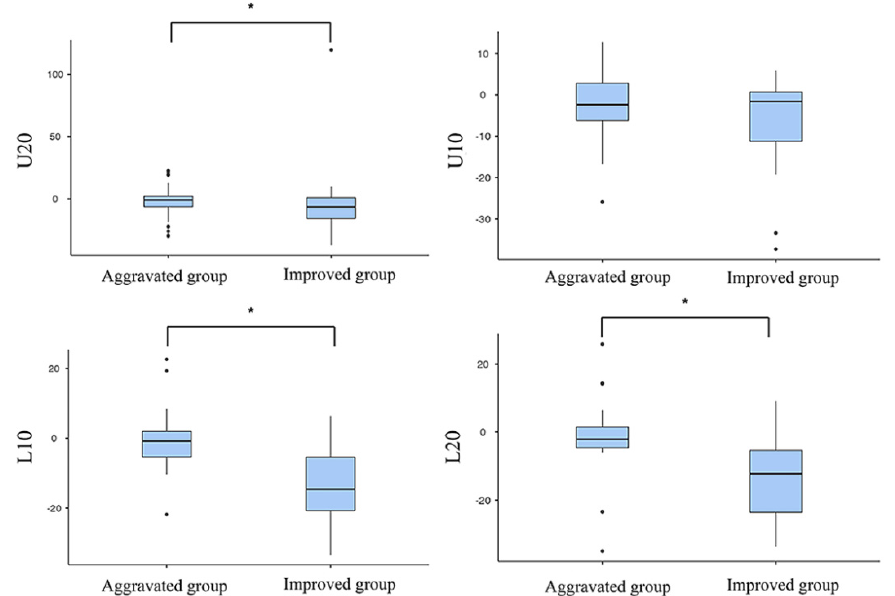
Figure 2. The fibrosis ratio at each level of the lower extremities. The fibrosis ratio within affected side between initial and follow-up CT scans was significantly different between the improved and aggravated groups at U20, L10, and L20. CT, Computed tomography; L10, 10 cm below the lower margin of the patellar bone; L20, 20 cm below the lower margin of the patellar bone; U10, 10 cm above the upper margin of the patellar bone; U20, 20 cm above the upper margin of the patellar bone. * p < 0.05.